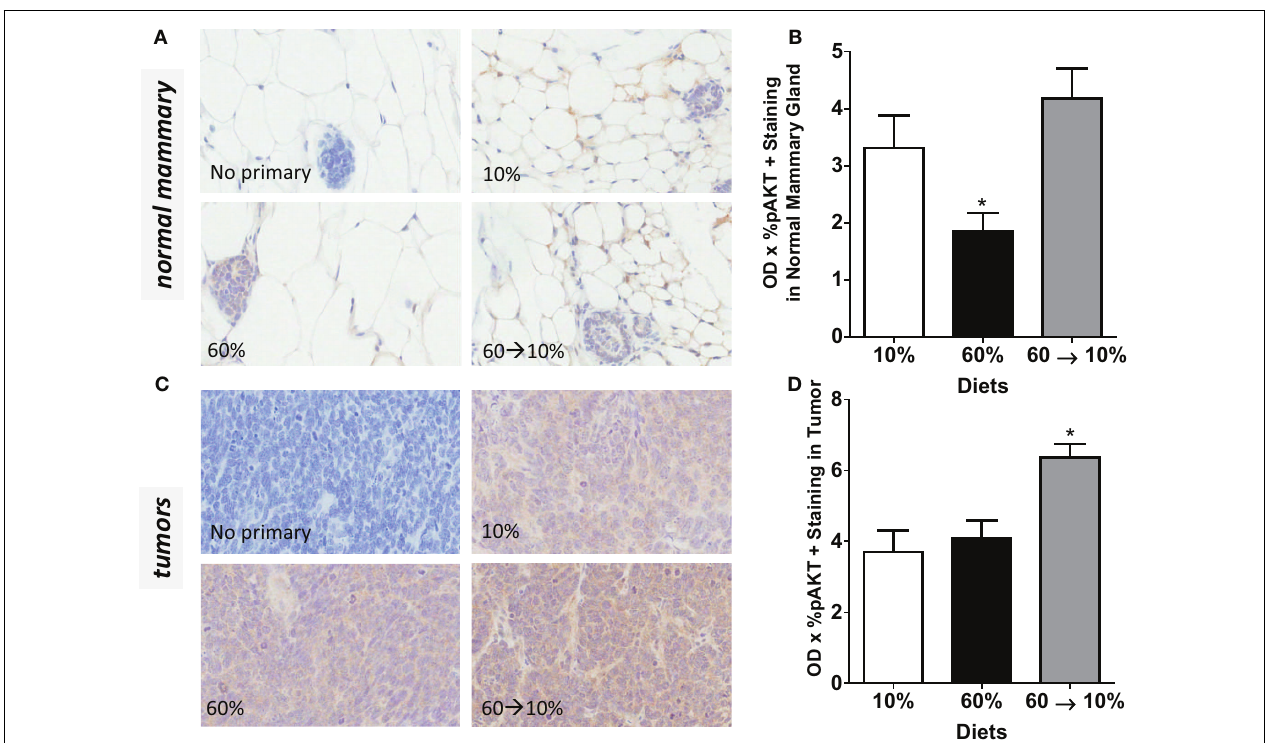
FIGURE 7 | pAkt is reduced by obesity and elevated by weight loss . (A,B) Representative IHC photomicrographs (40 × ) and pAkt quantified in normal mammary [* 10% ( P = 0.039) and 60 → 10% ( P = 0.001) vs. 60%]. (C,D) Representative photomicrographs (40 × ) and tumor